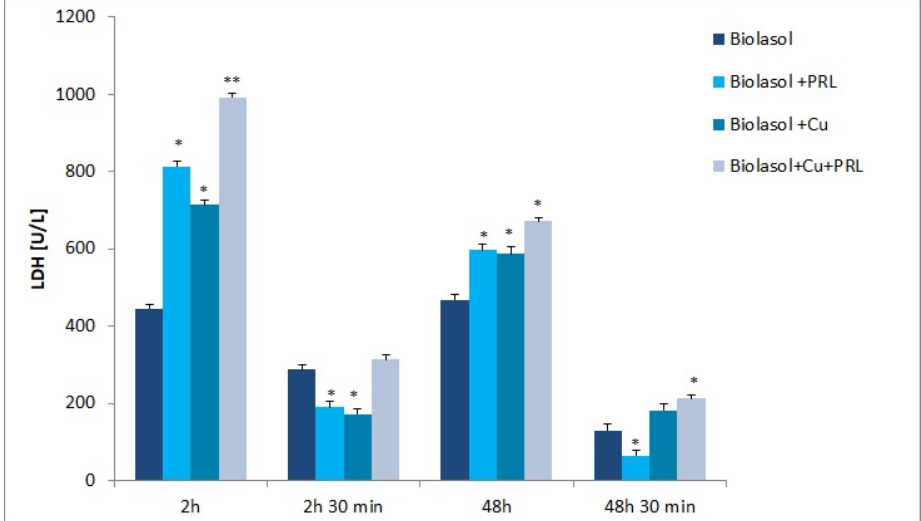
Figure 3. LDH activity in collected perfusate samples. The values are expressed as mean ± SEM. Data were analysed by one-way ANOVA and Bonferroni post hoc tests; n = 10; * p < 0.05; ** p < 0.01 compared to the control group (Biolasol).